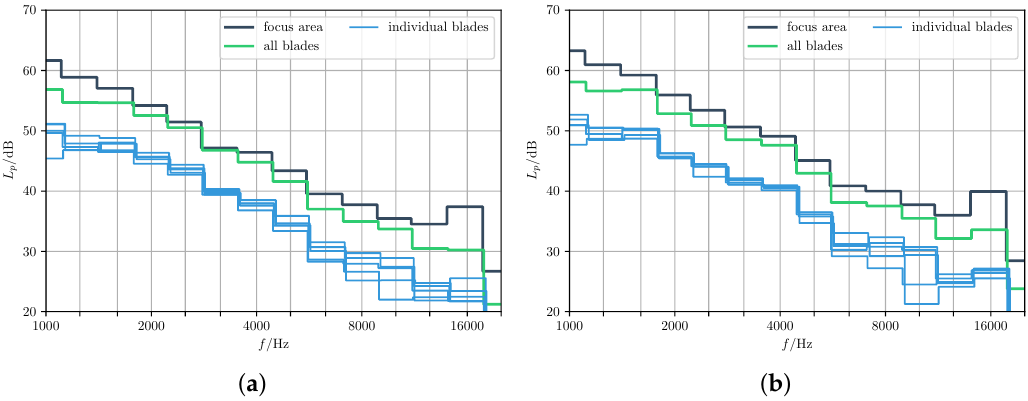
Figure 13. One-third octave band spectra for all blades (green), the individual blades (blue) and the whole focus area (black) obtained with the spiral array and DAMAS deconvolution. ( a ) Using barycentric interpolation and ( b ) using radial basis function